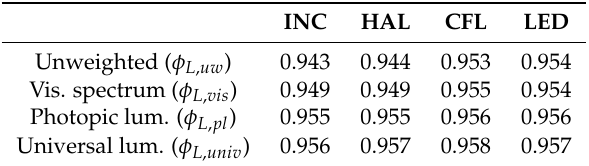
Table 5. Exergy-to-energy ratios ( φ L ) for each lamp and each weighting function ( f λ ), given by Equation (35).